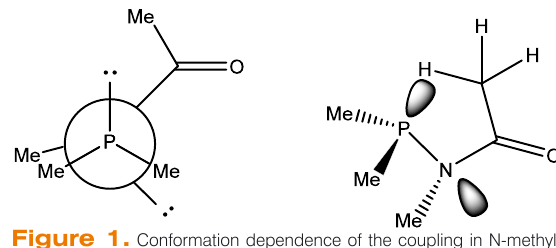
Figure 1. Conformation dependence of the coupling in N-methyl,